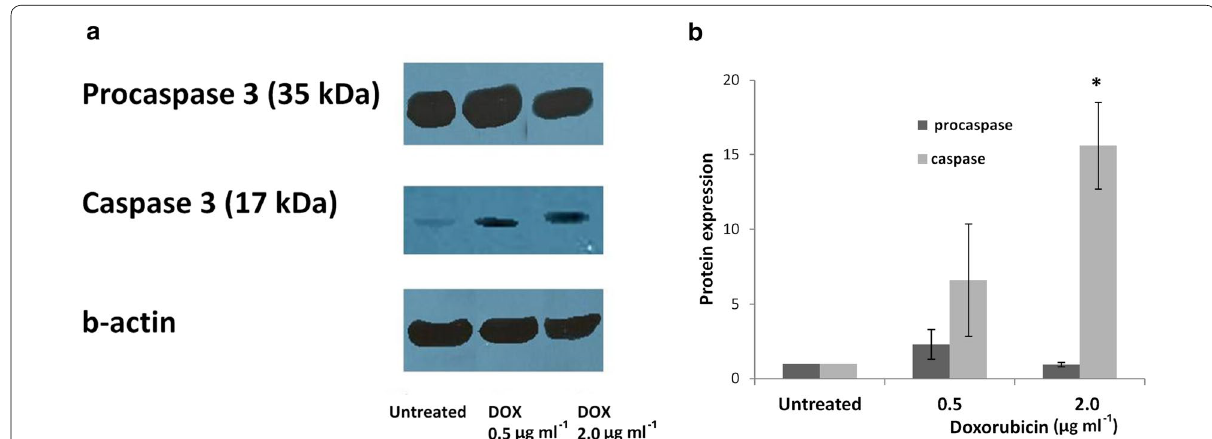
Fig. 5 a Western blots and b densitometric quantification, showing the caspase-3 level in HL-60 cells after treatment with doxorubicin. * p comparison with control (G-test). Bars represent standard